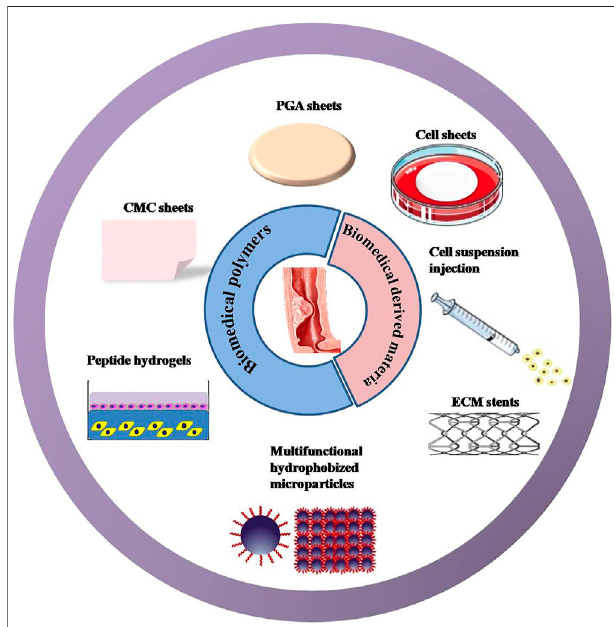
FIGURE 2 | New strategies that have been reported to prevent post- ESDesophagealstricture.Approachesinvolvebiomedicalpolymers:including polyglycolic acid (PGA)/carboxymethyl cellulose (CMC) sheets, peptide hydrogels, and multifunctional hydrophobized microparticles. Methods covering the biomedical-derived materials incorporating cell sheets, cell suspension, and extracellular matrix (ECM) stents.